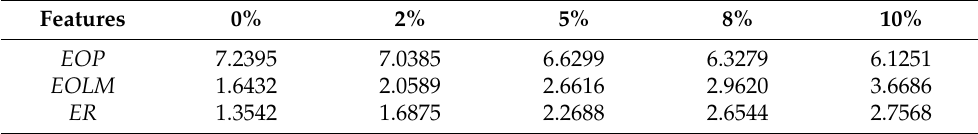
Table 4. Features of surge velocity signal in the time-frequency domain for different fault